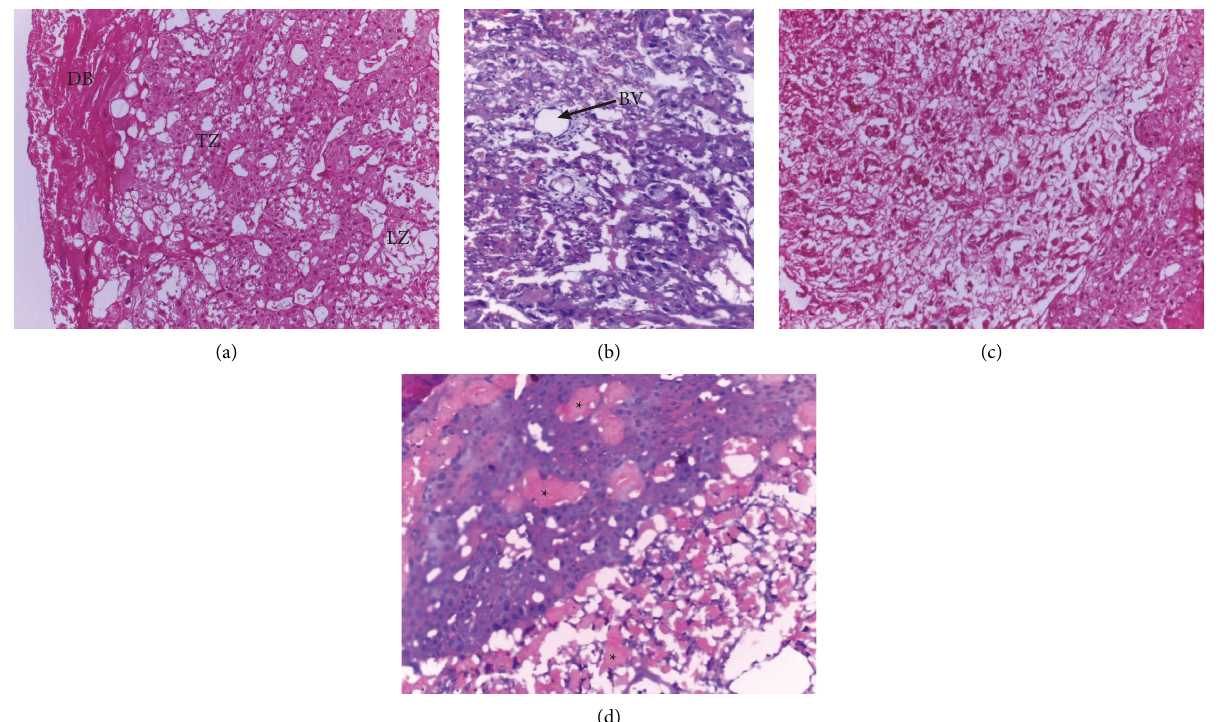
Figure 2: Photomicrograph of rat placenta of group IV, (a) group V, and (b) group I (c) showing normal architecture of the placenta and group II (d) showing hematoma in the different zones of the placenta ( ∗ ); DB: Decidua basalis, TZ: Trophoblastic zone, LZ: Labyrinthine zone, BV: Blood vessel; H and E stain, 100 × total magnification.